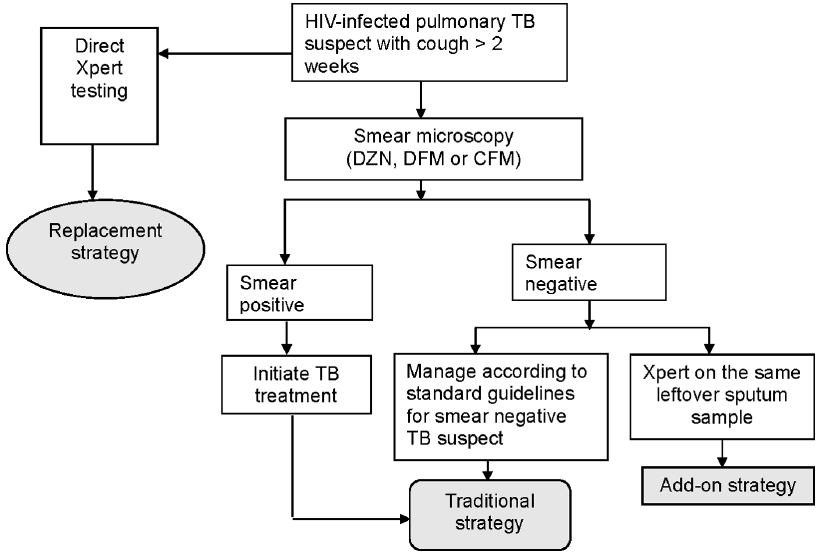
Figure 1. Hypothetical Xpert implementation in either a replacement or an add-on strategy. DZN = Direct Ziehl Neelsen, DFM = Direct Fluorescent Microscopy, CFM = Concentrated Fluorescent Microscopy, Xpert = Xpert MTB/RIF test.